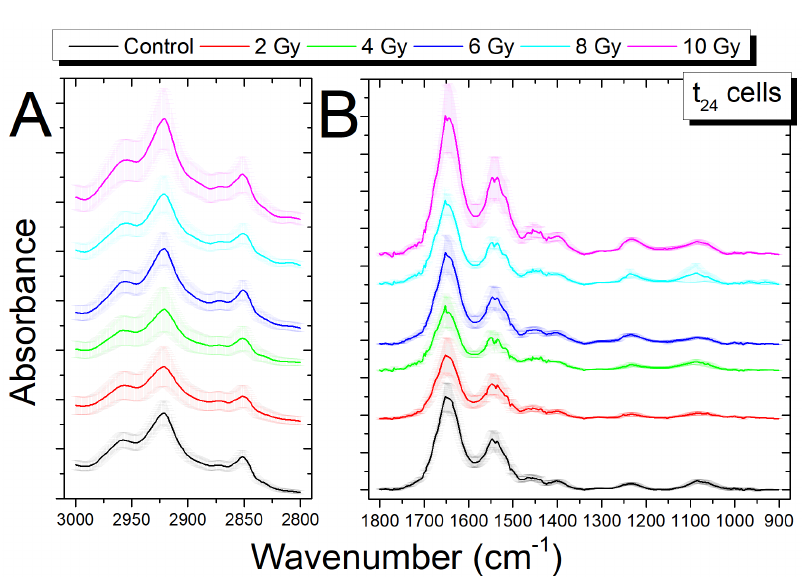
Figure 4. Comparison of average FTIR spectra in the region 3000–2700 cm − 1 ( A ) and in the region 1800–900 cm − 1 ( B ) between the control cells (0 Gy) and irradiated cells (2; 4; 6; 8; 10 Gy) fixed 24 h after irradiation; the spectra are shifted in absorbance to allow the comparison, data are presented as MEAN ± SD.